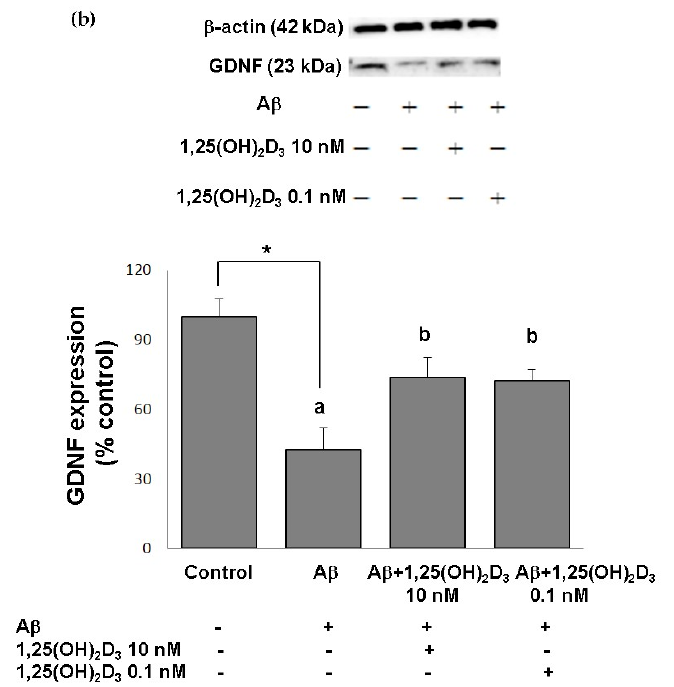
Figure 2. E ff ects of 1,25(OH) 2 D 3 on A β -induced changes in vitamin D receptor (VDR) ( a ) and glial cell line-derived neurotrophic factor (GDNF) ( b ) protein expressions. SH-SY5Y cells were incubated with 1 µ M A β (25-35) prior to the addition of 0.1 and 10 nM 1,25(OH) 2 D 3 for 24 h.* Significantly di ff ers from the control group (statistical analysis was performed using Student’s t test). Bars of A β , A β + 0.1 nM 1,25(OH) 2 D 3 , and A β + 10 nM 1,25(OH) 2 D 3 with di ff erent letters significantly di ff er from each other ( p < 0.05) (statistical analysis was performed using one-way analysis of variance